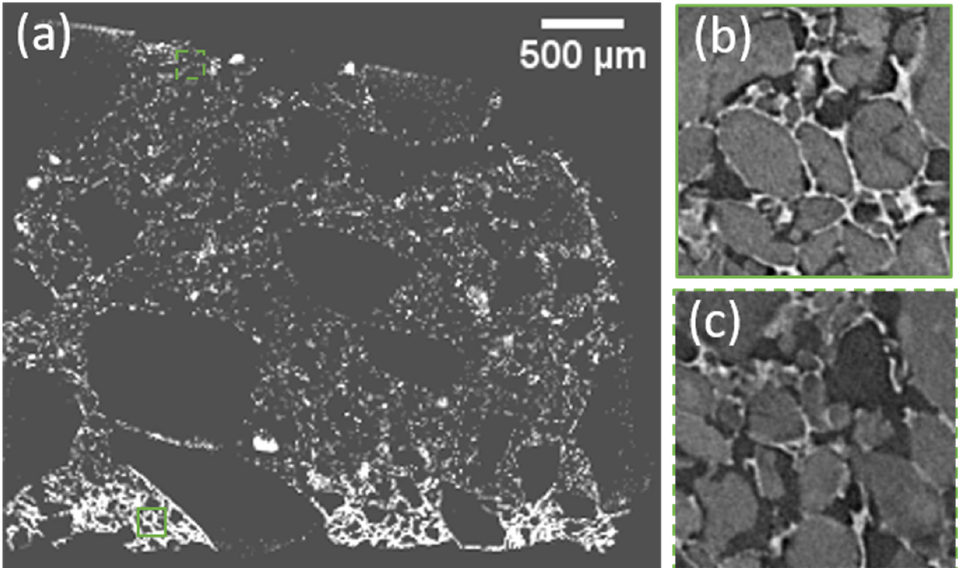
Figure 3. ( a ) Full cross-section of a segmented prismatic sample X binder, (pores and SAP are black), showing that on the bottom the volume fraction of binder is higher and the thickness of the binder is greater,(green squares locate zoom shown in ( b , c )); ( b ) 200 µm × 200 µm bottom zoom (green square in ( a )) showing SAP sealed by a thick continuous binder skin near the sample edge; ( c ) 200 µm × 200 µm top zoom (green interrupted line square in ( a )) showing a thin and disrupted binder skin of a few microns thick, far from the sample edge. ( b , c ) the binder is white, SAP is light gray, and the IP is dark.